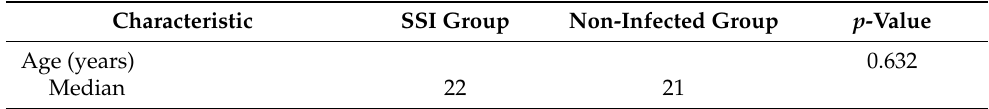
Table 4. Characteristic continuous variables of the surgical-site infected and non-infected